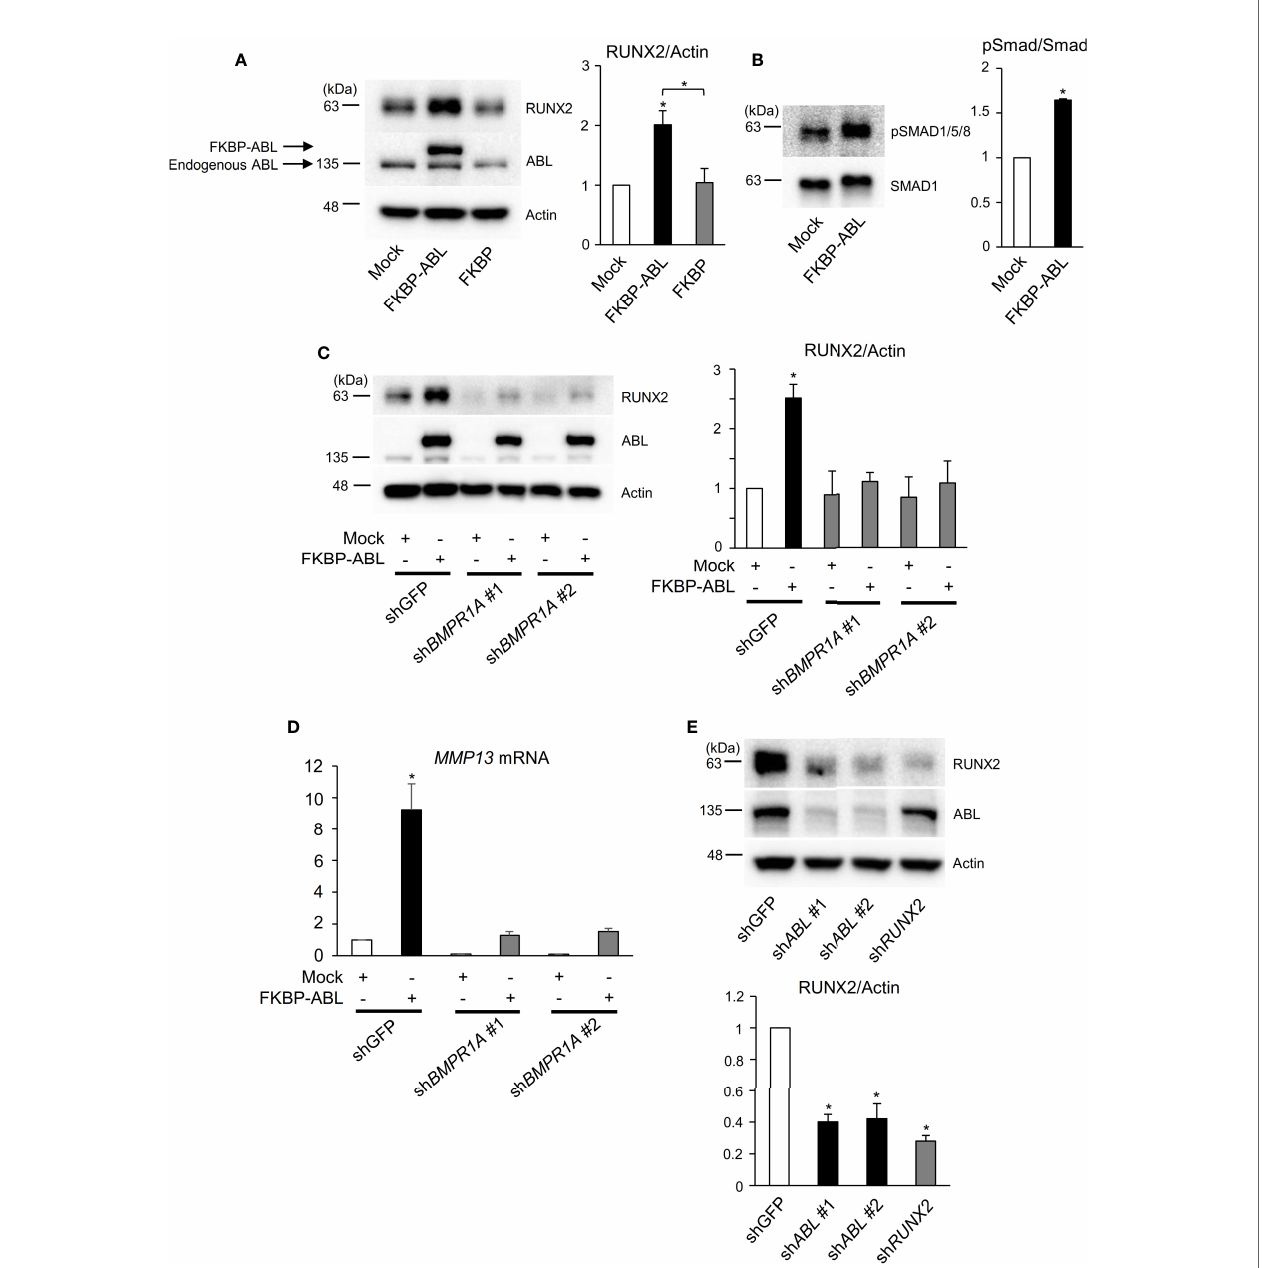
FIGURE 4 | ABL regulates RUNX2 expression through control of the BMP-SMAD pathway. (A, B) Saos-2 cells were infected with an empty vector control or an FKBP-ABL- or FKBP-expressing retroviral vector. Whole cell lysates were probed with the indicated antibodies for Western blot analysis. (C) Saos-2 cells were infected with an empty vector control or an FKBP-ABL-expressing retroviral vector in the presence of shGFP or sh BMPR1A . Whole cell lysates were probed with the indicated antibodies for Western blot analysis. (D) Quantitative PCR analysis of MMP13 mRNA expression in cells in (C) . n = 3. (E) MDA-MB231 cells were infected with an shGFP-, sh ABL- or sh RUNX2 -expressing vector. Whole cell lysates were probed with the indicated antibodies for Western blot analysis. P values were determined by ANOVA with Tukey – Kramer ’ s post hoc test. Data are presented as means ± SEM. *P <